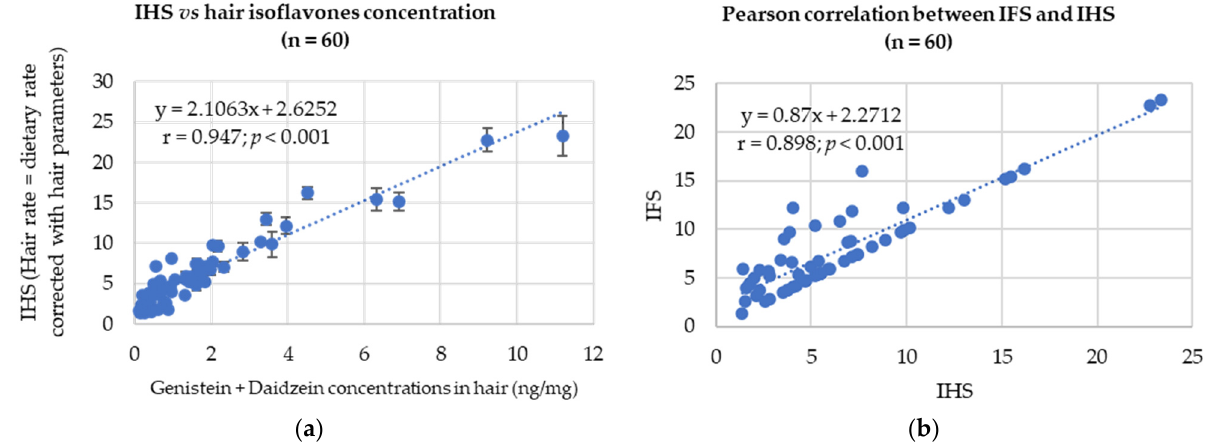
Figure 1. Pearson correlations between HIS and either total hair isoflavones or IFS, calculated for the whole 60 volunteers ( p < 0.001): ( a ) Pearson correlation between IHS and hair isoflavones (GEN+DAI) concentration; ( b ) Pearson correlation between IFS and HIS.